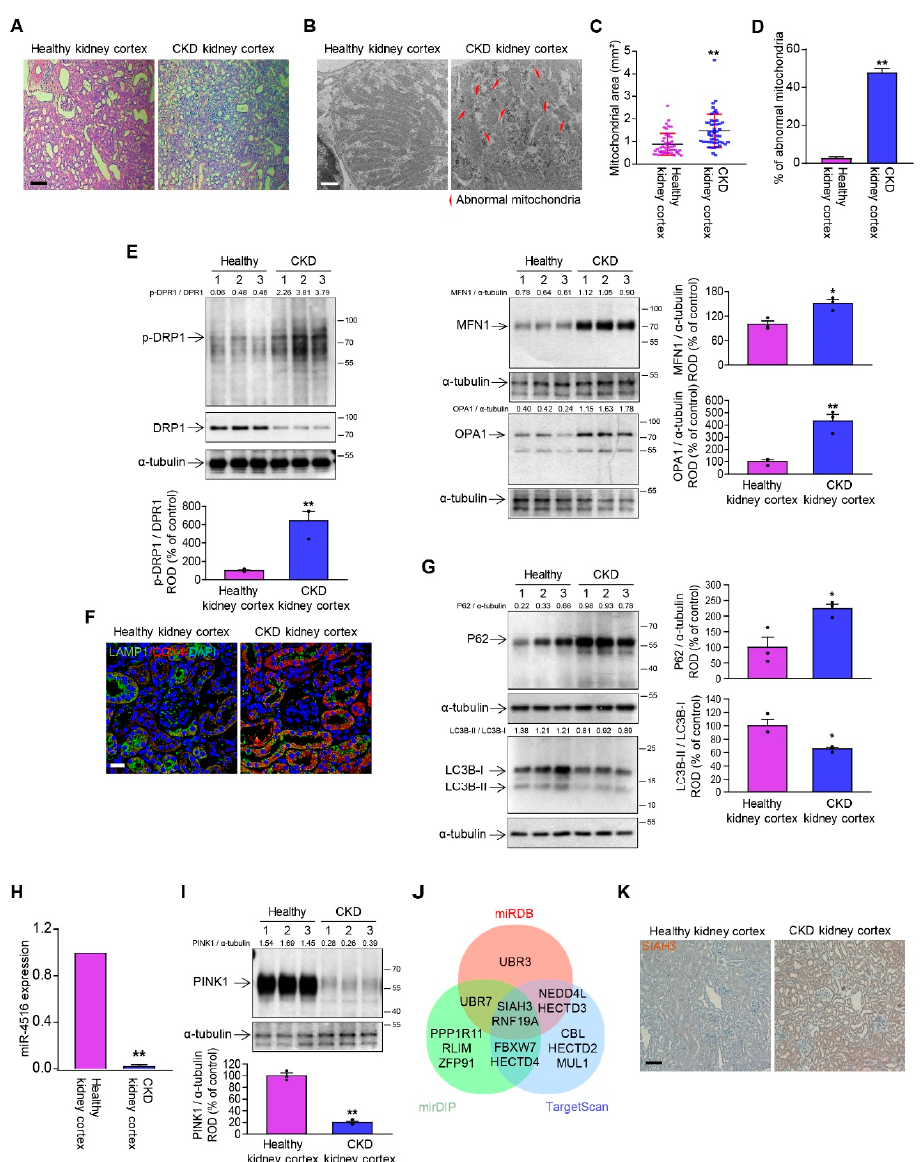
Figure 1. The miR-4516/SIAH3 pathway is involved in dysregulated mitophagy in fibrotic kidney of CKD mice. ( A ) H&E staining of kidney cortex of CKD mice with healthy control (scale bar = 100 µ m). ( B ) Representative TEM images of mitochondria in renal cortex of healthy and CKD mice (scale bar = 1 µ m). ( C , D ) Quantification of mitochondrial size and number of abnormal mitochondria in renal cortex of healthy and CKD mice ( n = 3). ( E ) Expression of p-DRP1 (S637), DRP1, MFN1, and OPA1 in renal cortex of CKD mice with healthy control. ( F ) Immunofluorescence data for lysosomal marker LAMP-1 (green) and mitochondrial marker COX4 (red) in CKD renal cortex region with healthy control (scale bar = 20 µ m). ( G ) Expression of P62 and LC3B in renal cortex of CKD mice with healthy control. Protein expression level were quantified by densitometry and normalized to α -tubulin levels ( n = 3). ( H ) Level of miR-4516 in renal cortex of CKD mouse as measured by qRT-PCR. ( I ) Expression of PINK1 in renal cortex of CKD mice. ( J ) Potential target genes of miR-4516 related to E3 ubiquitin protein ligase as reported by three different microRNA databases. SIAH3 was suggested by all three databases as indicated at the intersection of the Venn diagram. ( K ) Representative IHC images for SIAH3 in renal cortex of CKD mice with healthy control. Protein expression level was quantified by densitometry and normalized to α -tubulin levels ( n = 3). The values represent mean ± SEM, * p < 0.05, ** p < 0.01 compared with renal cortex of healthy mice. Statistical significance was assessed with unpaired Student’s t -test. The α -tubulin was used as Western blot loading control for whole tissue